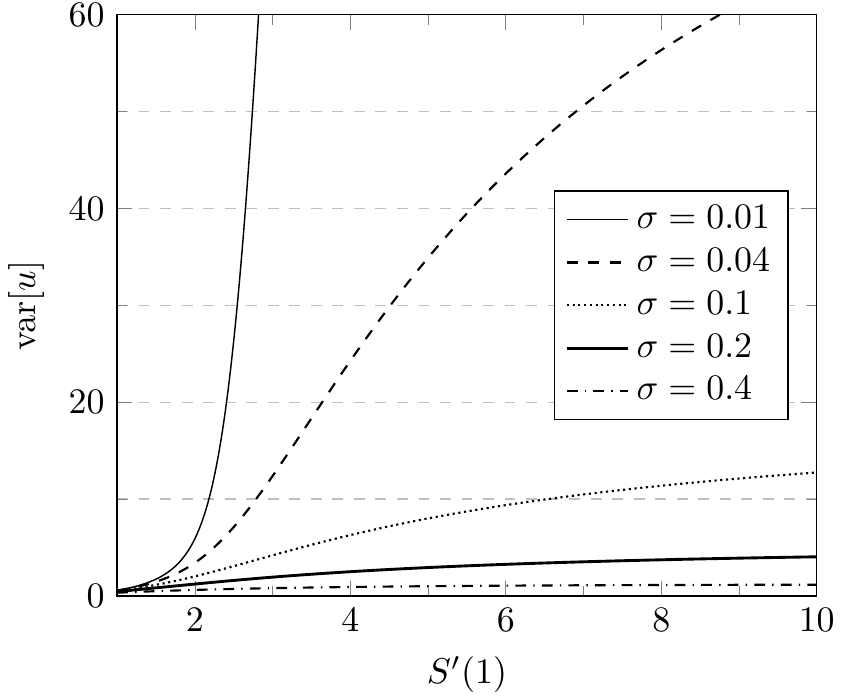
Figure 7. Variance of the system content var [ u ] versus S (cid:48) ( 1 ) for Poisson service times, Poisson arrivals with λ = 0.4 and different values of σ